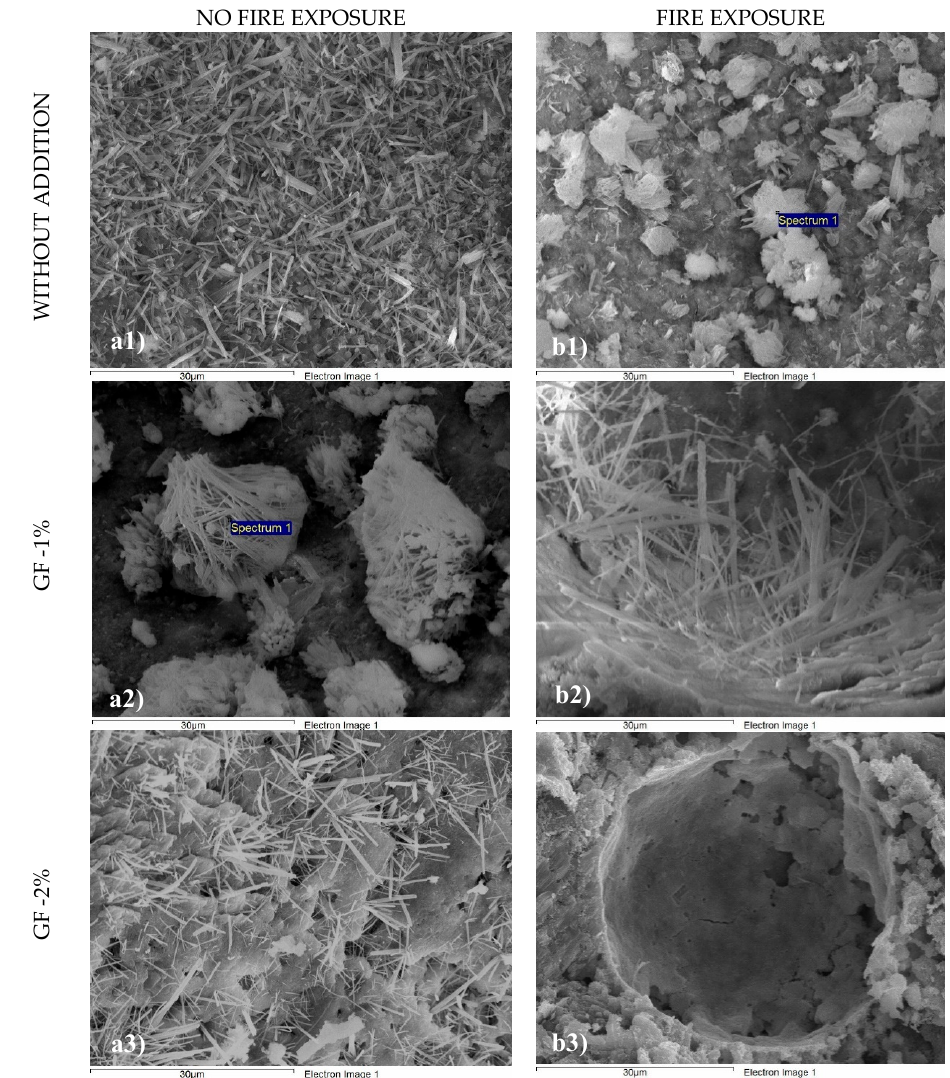
Figure 9. Scanning electron microscopy at 2000 magnifications in test pieces SA, GF-1% and GF-2%. ( a ) Before thermal aggression; ( b ) After thermal aggression.